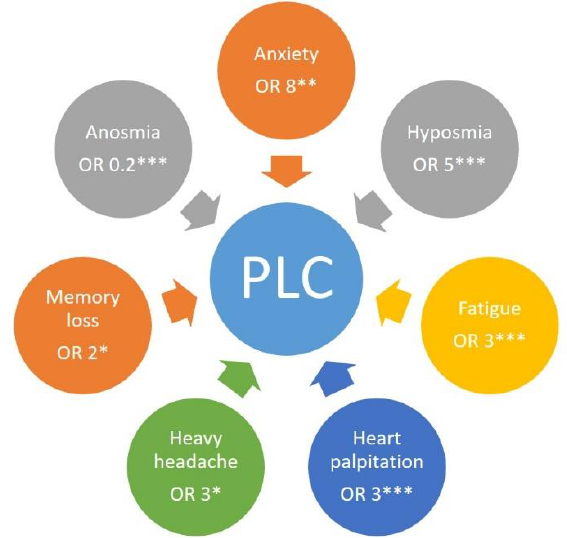
Figure 2. Self-reported PLC symptoms, proportion of individuals who have recently suffered from COVID-19, % percent.